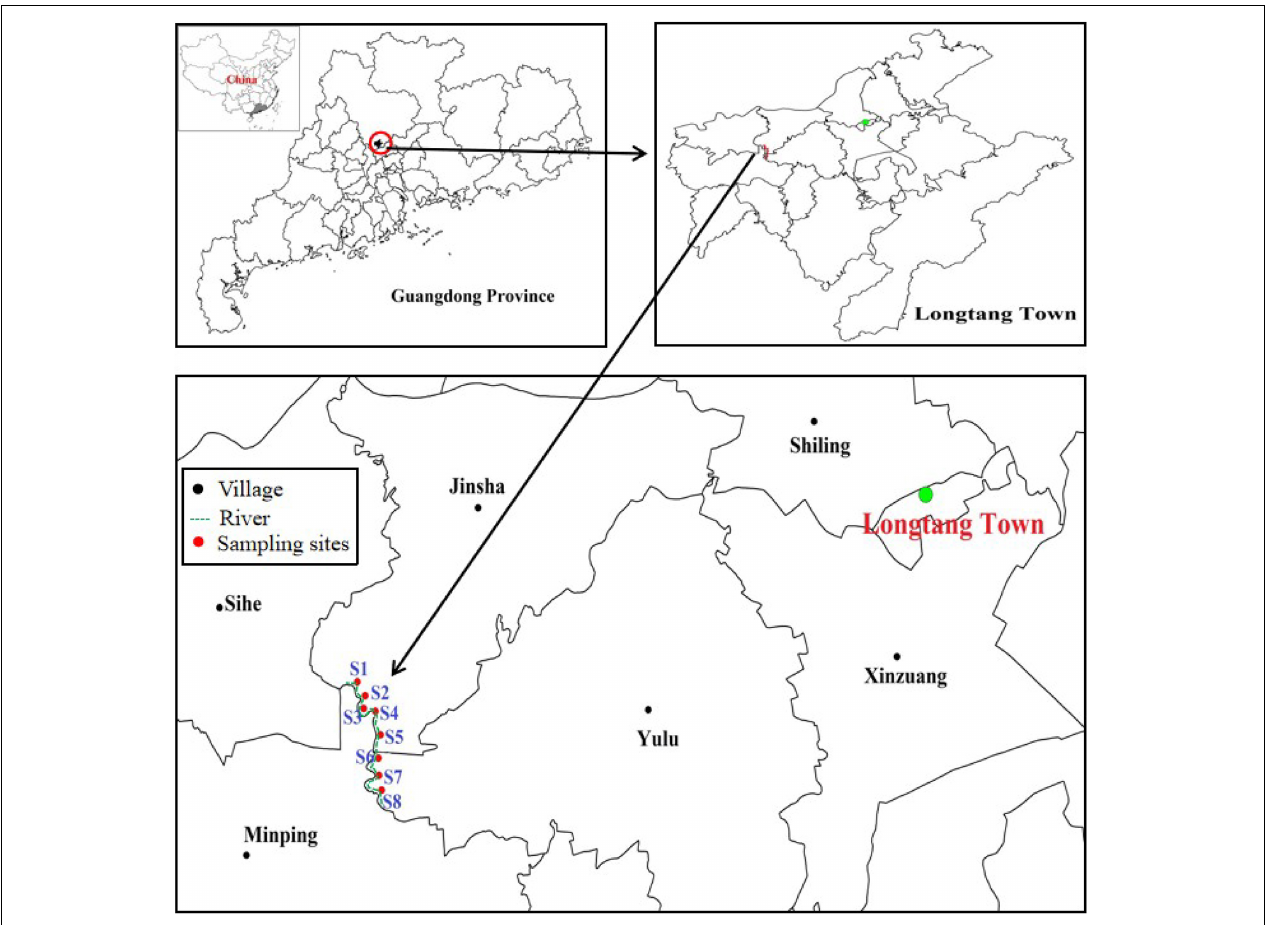
FIGURE 1 | Map of sampling locations along the river at Longtang town, Guangdong Province, China. The longitude and latitude for all samples were shown in Supplementary Table 1